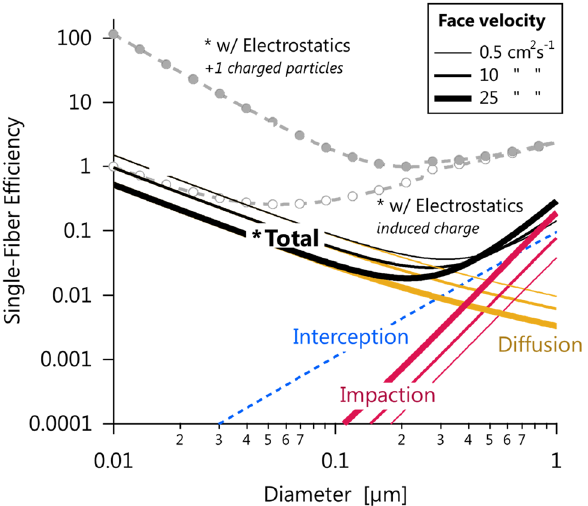
Figure 3. Modelled single-fibre filtration efficiencies for different filtration mechanisms across aerosol-particle sizes relevant to the PFE test methods. The abscissa represents aerodynamic diameter. The physical properties of PSL were assumed for simplicity. The face velocities span the ASTM F2299/F2100 test method at its lowest, NIOSH-like, and maximum face velocities, respectively. Interception capture is independent of face velocity. The “*Total” curve represents an uncharged filter with no electrostatic capture. An electrostatically charged filter may additionally capture uncharged particles by induced-charge (dielectrophoretic) forces (open circles) and charged particles by additional coulombic forces (filled circles), as illustrated for the 10 cm 2 s −1